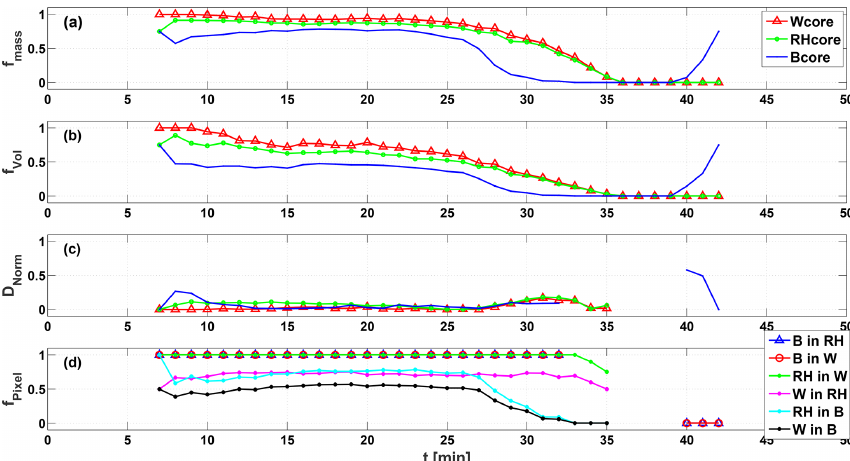
Figure 3. Temporal evolution of selected core properties, including (a) the fraction of the cores’ mass from the total cloud mass ( f mass ), (b) the fraction of the cores’ volume from the total cloud volume ( f vol ), (c) the normalized distance between the cloud centroid and core centroid ( D norm ), and (d) the fraction of cores’ pixels contained within another core ( f pixel ), including all six permutations. See panel legends for descriptions of line